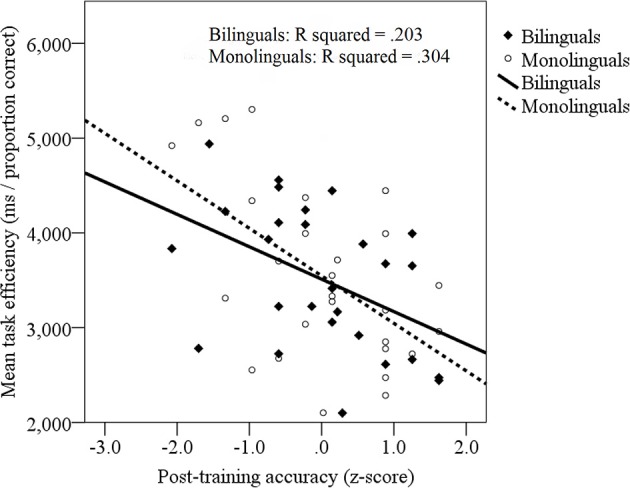
Relationship between target identification efficiency (ms/proportion correct) during sound-to-symbol matching and participants' previous sound-to-symbol learning success (accuracy, z-transformed). Bilinguals: filled diamonds, solid line; Monolinguals: open circles, dotted line.